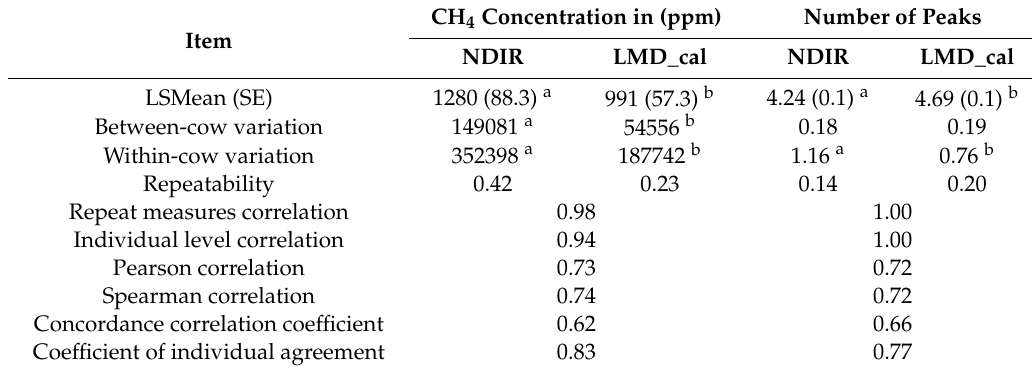
Table 1. Sources of (dis)agreement for the CH 4 concentration and number of peaks.